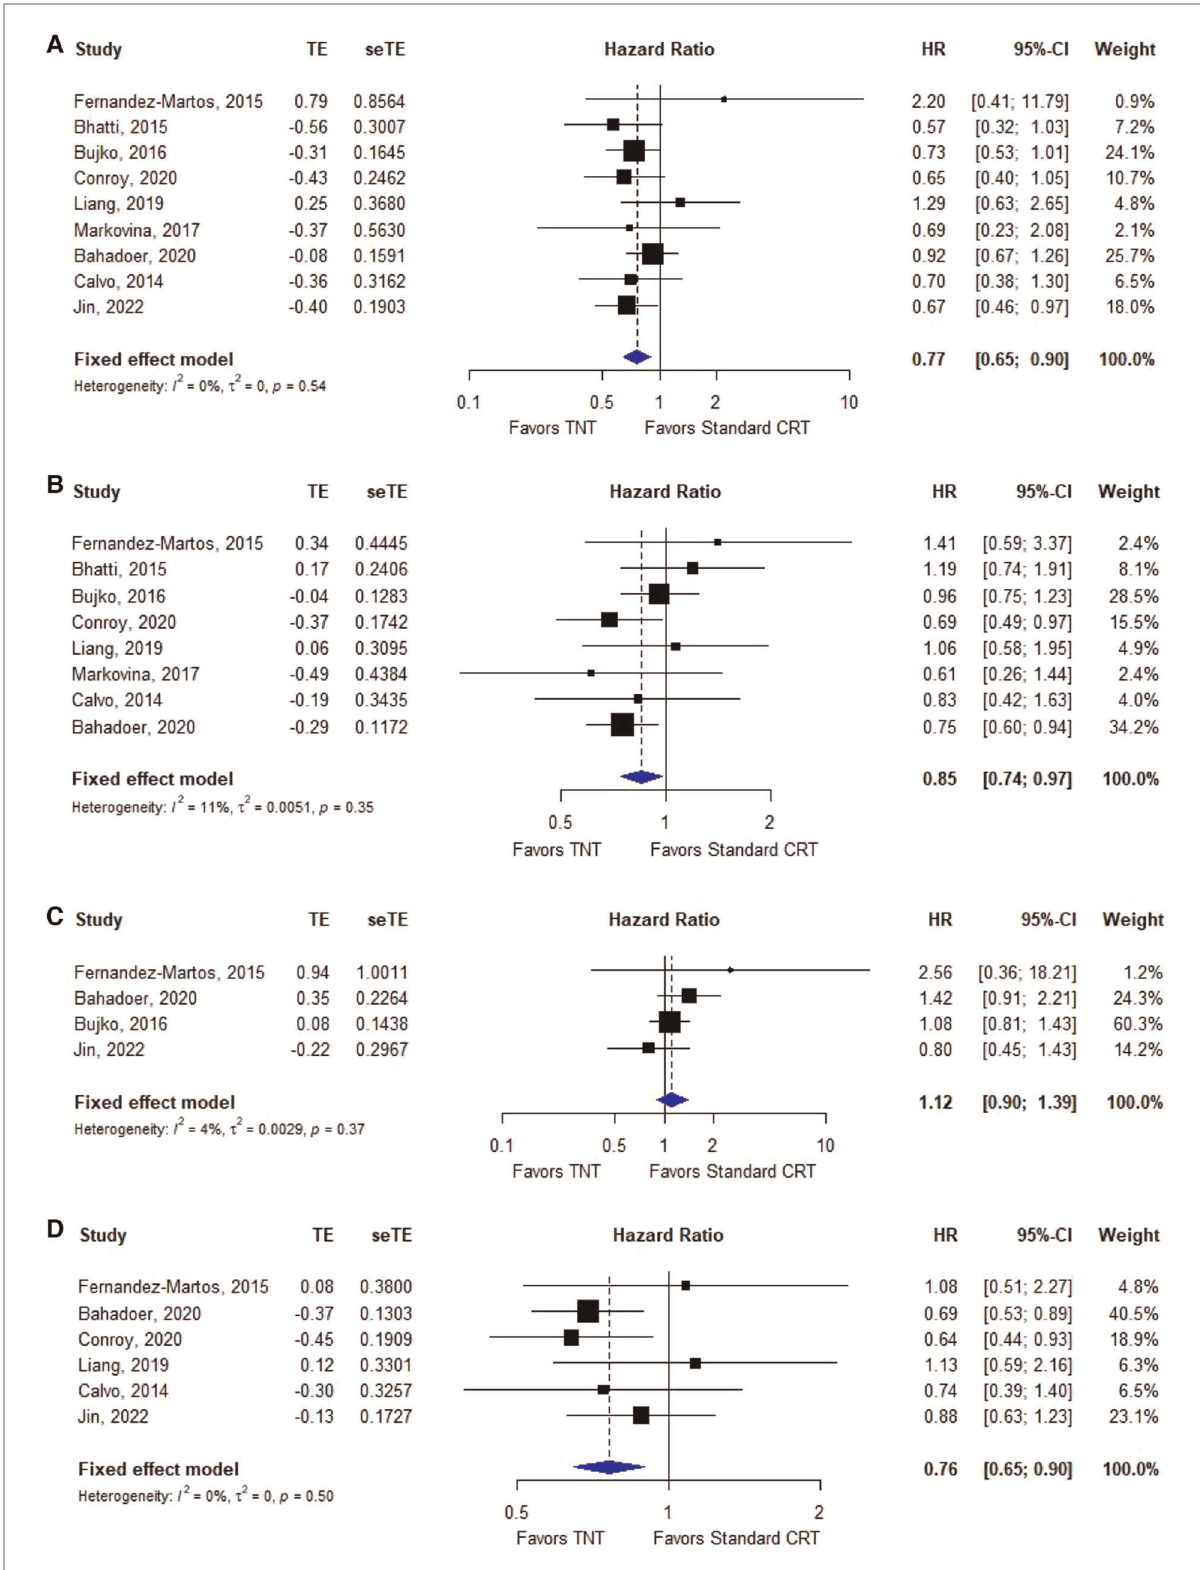
FIGURE 3 Forest plots for the meta-analyses. ( A ): OS; ( B ): DFS; (C): LRFS; (D):